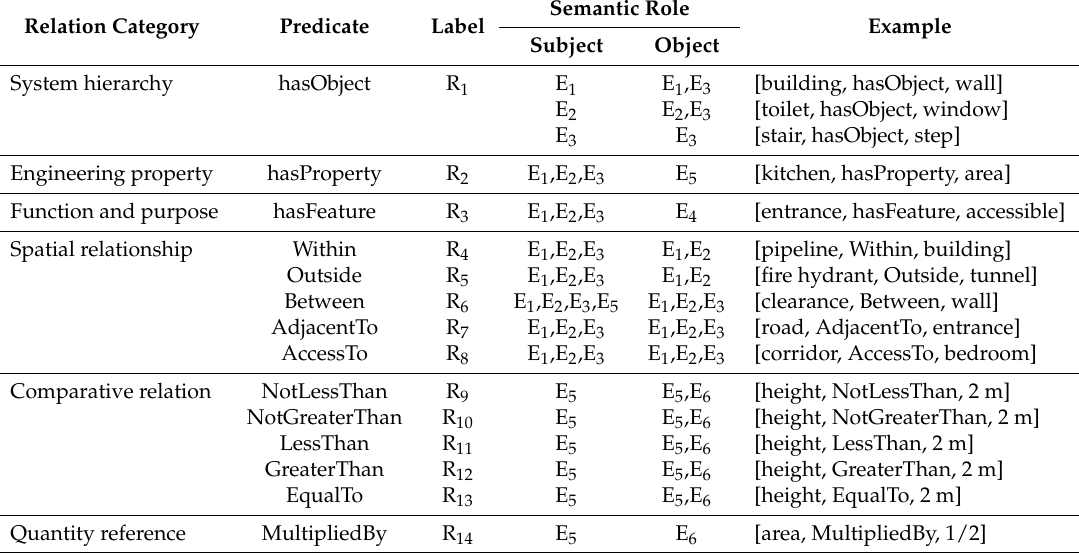
Table 2. Predicate relation categories and the alternative semantic roles of associated